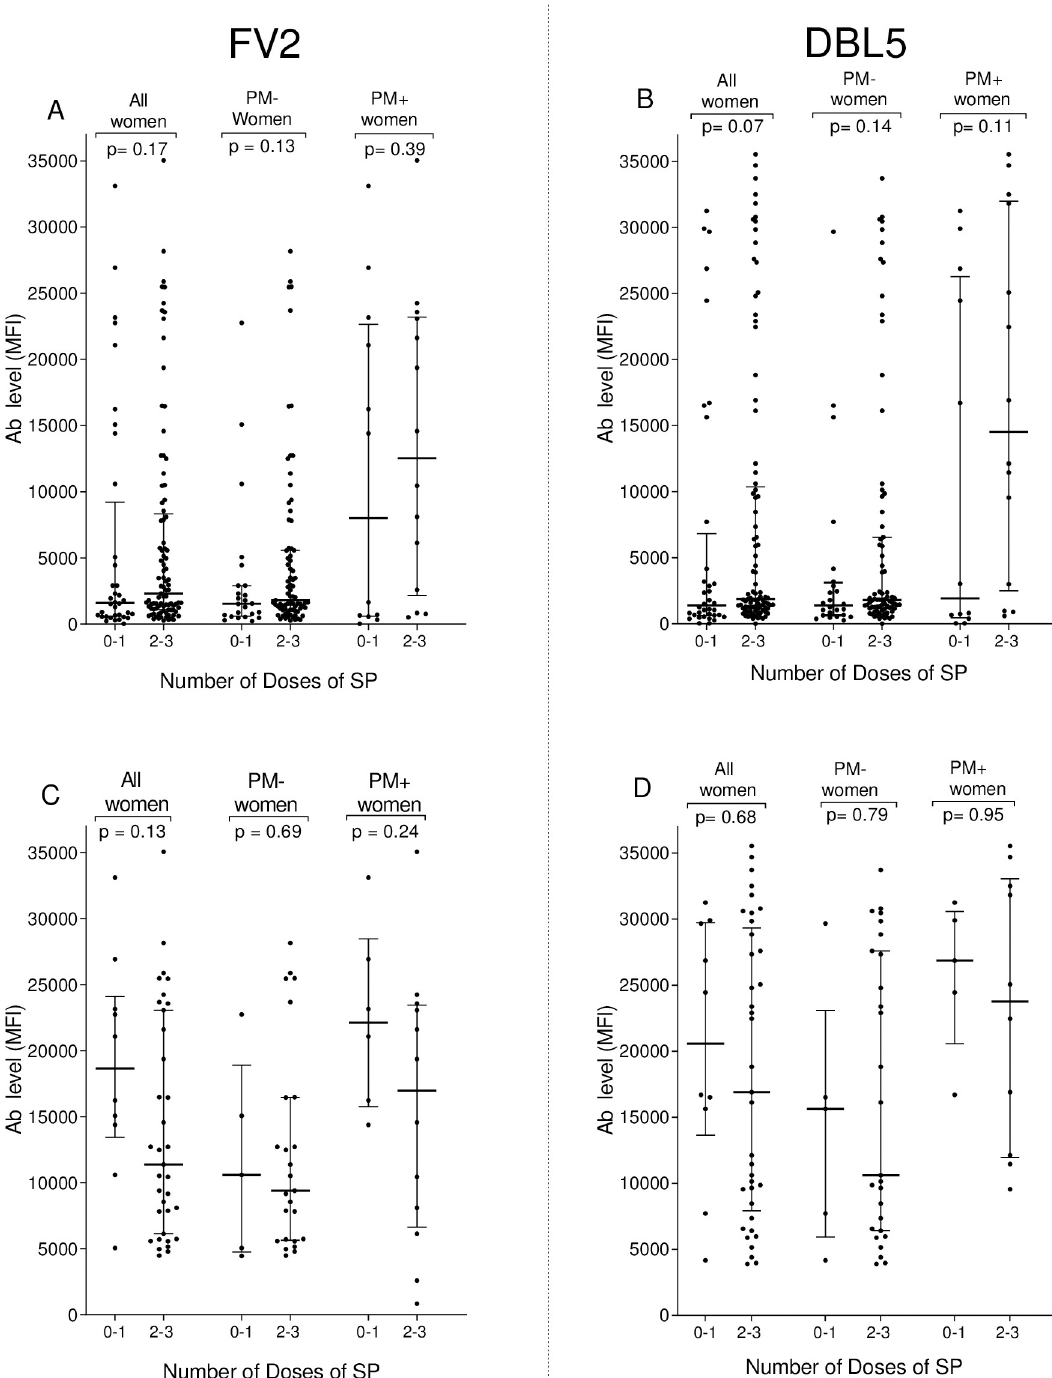
Fig 3. Influence of number of doses of SP on Ab levels to VAR2CSA (FV2 and DBL5) at delivery. Mann-Whitney Rank Sum test was used to compare median plasma Ab levels to VAR2CSA between groups. A and B: IgG levels for all women (n = 130). C and D: IgG levels for Ab-positive women (n = 45 women for FV2, n = 47 women for DBL5). MFI: median fluorescence intensity; IQR: interquartile range; Ab: antibody; The cut-off for Ab-positivity was 4,483 MFI for FV2 and 3,232 MFI for DBL5. Horizontal bars represent the group median +/- 25%